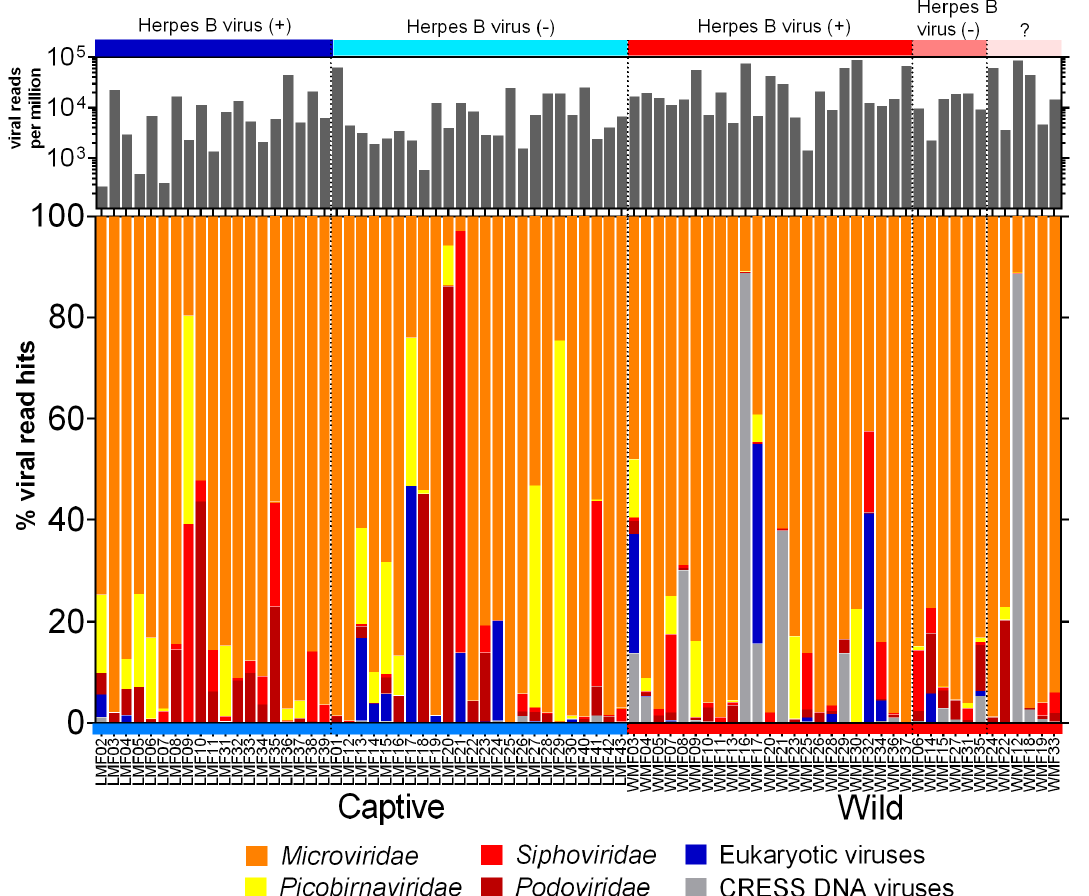
Figure 1. The percentage of viral reads matching six virus groups among wild and captive macaques. The color labels at the top of the figure present the herpes B virus infections. The black bar plot above the color bar shows the normalized total viral read numbers matching viruses shown below.